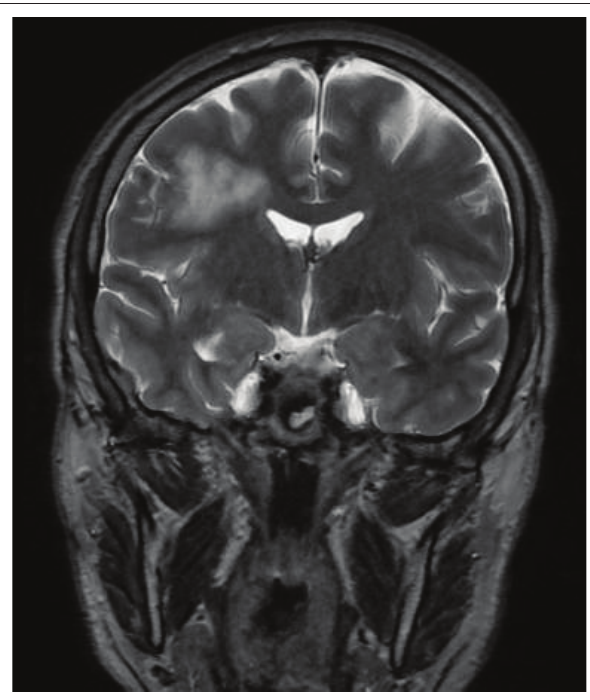
FIGURE 3: Coronal T2-weighted MR image.